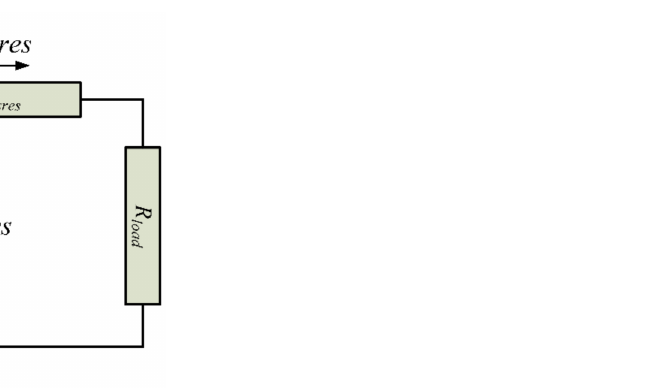
Figure 2. Impedance and current distribution (ideal) for class E and enhanced topologies with auxiliary resonant